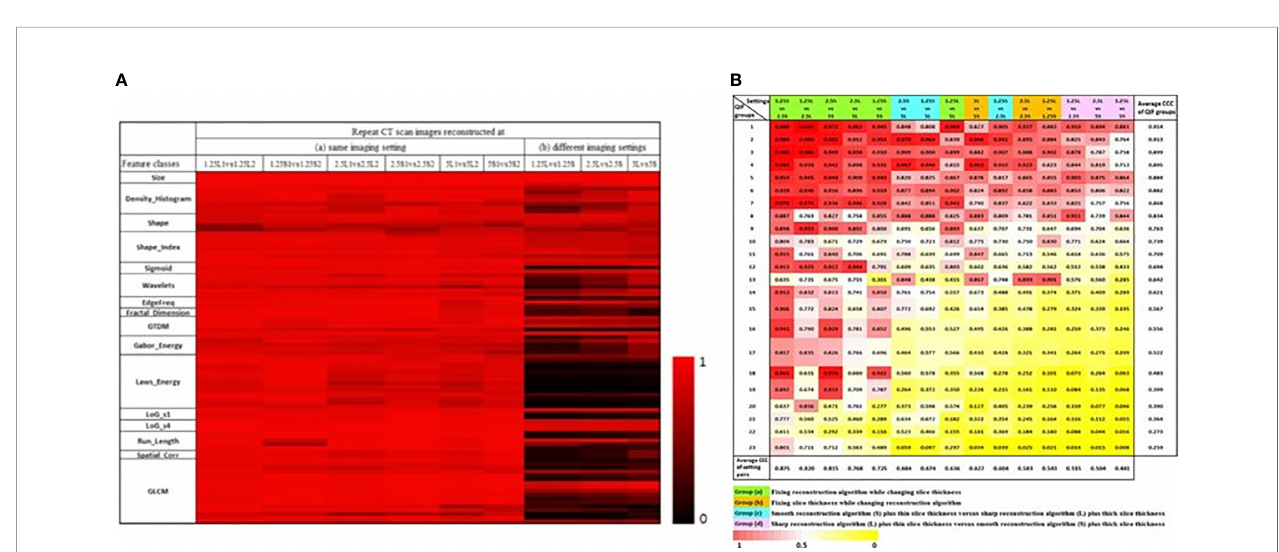
FIGURE 4 | (A) CCC heat map of radiomics features. The CCC (0 to 1) of the studied 89 radiomics features were computed from same-day repeat CT images reconstructed at (a) six identical imaging settings or (b) three different imaging settings. The brighter the red color, the higher the CCC values (i.e., the more reproducible) of a feature computed for the repeat scans (31). (B) CCC heat map of 23 non-redundant radiomics feature groups (rows) under 15 inter-setting comparisons (columns). Columns are arranged in descending order according to the average CCC of the inter-setting comparisons. Rows are arranged in descending order according to average CCCs of non-redundant feature groups